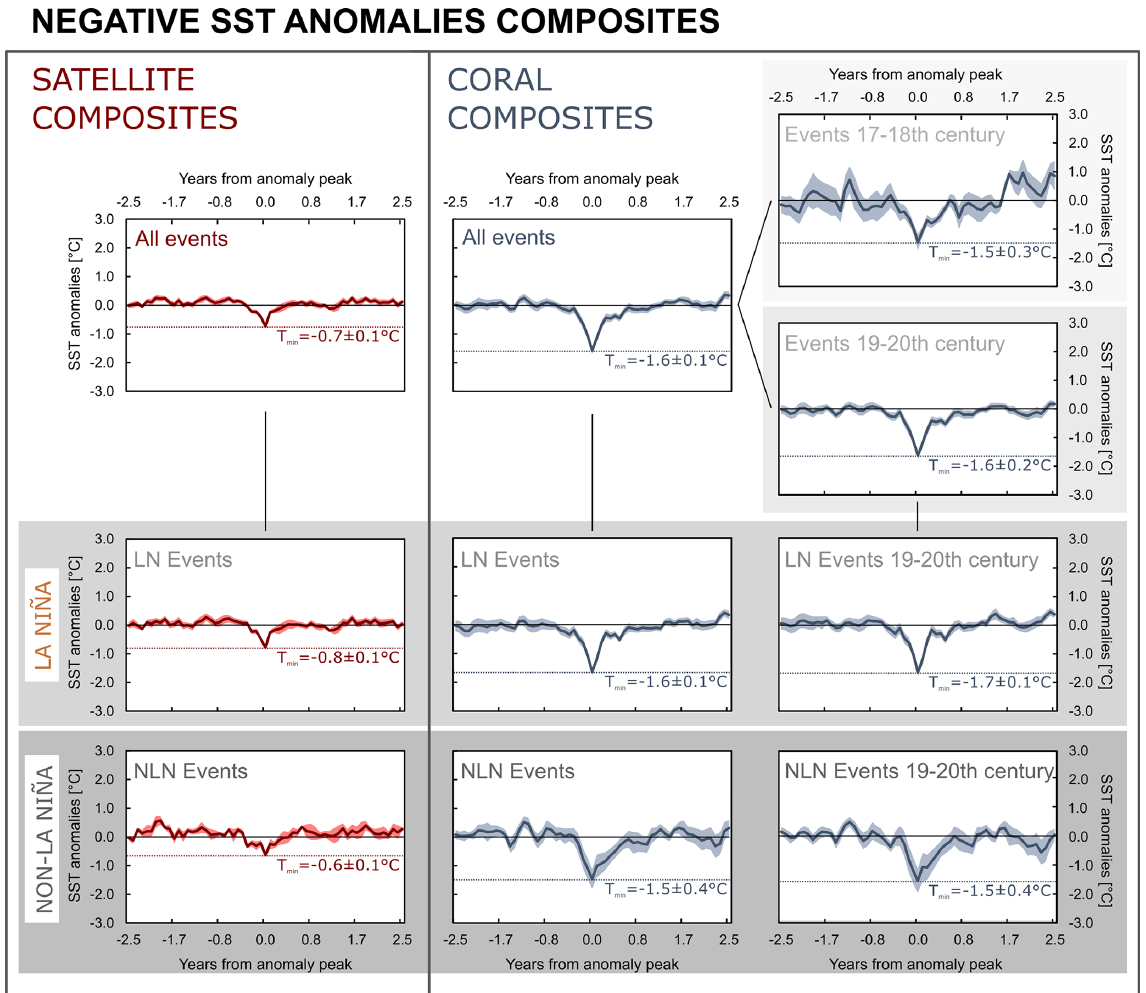
Figure 8. Negative SST anomaly (La Niña and non-La Niña events) composite records of AVHRR satellite (left; red) and coral SST (right; blue) records. Additionally, composites of anomaly events separated by 17–18th and 19–20th century events and by La Niña and non-La Niña events were generated. Shaded areas below and above the curves show the standard error for the mean values of the composite records. See Table 4 for an overview of the events that were selected for generating the